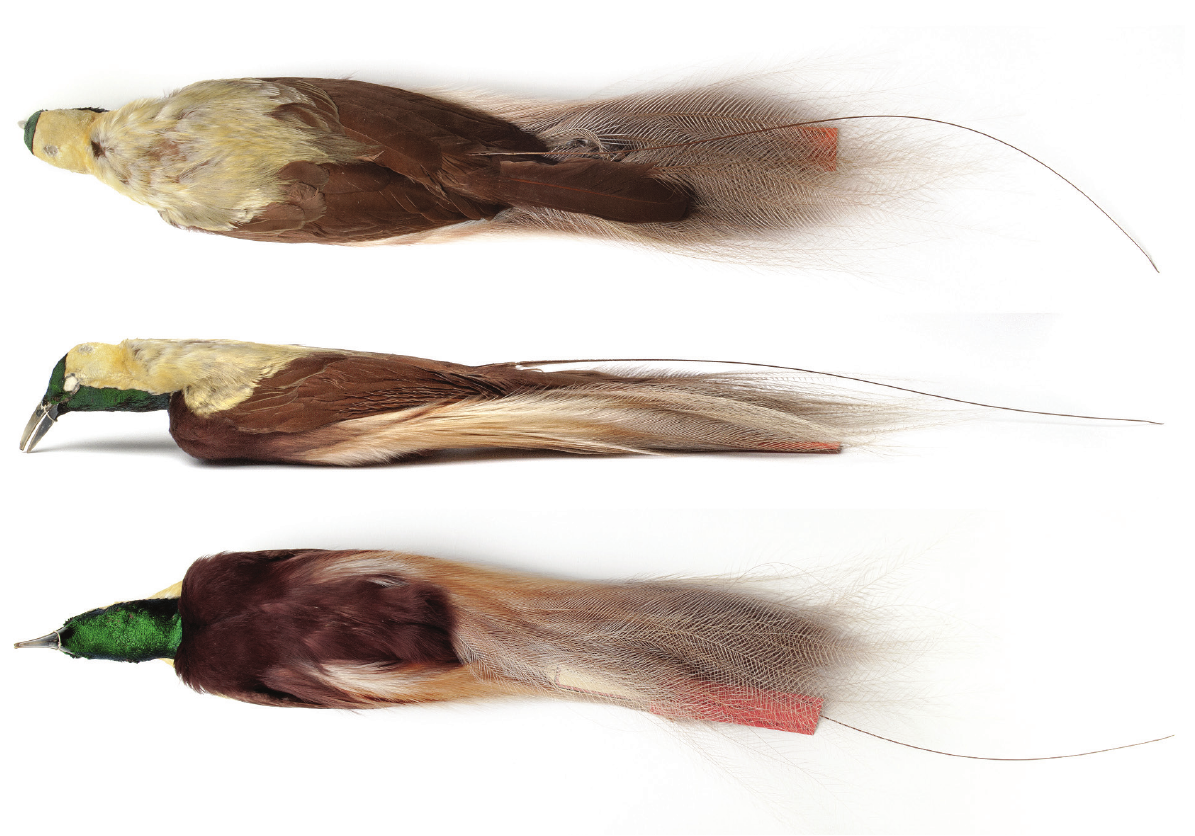
Figure 3. The holotype (ZMB 31049) of Paradisaea maria Reichenow, 1894, in dorsal, lateral, and ventral view. Photos by H. J. Goetz (Museum für Naturkunde,